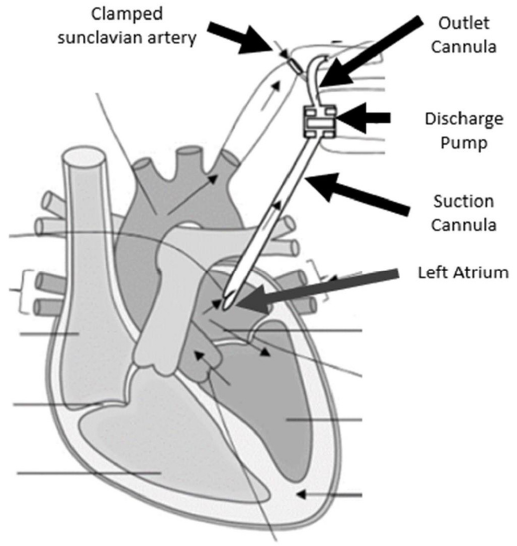
Figure 1. An illustration of how the developed pump will be implanted. The speci fi cations for this pump include a centrifugal pump with a volute and a semi- open impeller. The impeller is driven by an electric motor with axial fl ow and magnetic levitation. The rotational speed should be between 2000 and 5000 revolutions per minute, with a continuous fl ow rate ranging from 0.05 to 0.5 L/min depending on the required ejection fraction. The pressure gradient should be approximately 80 mm Hg to overcome the pressure loss in the organs supplied by the subclavian artery. It is important to note that the two pump prototypes are not commercially available and will be designed and manufactured in-house. In this study, two geometric variants of the pump were designed to meet the speci fi - cations and they di ff ered in blade thickness. The impellers and volutes were designed using internal 3Dturbo software, V2.0 a comprehensive solution for the design of single- stage centrifugal pumps. This software also allowed for the reverse engineering of centrif- ugal pumps and facilitated the calculation of performance in design and o ff -design con- ditions using a speci fi c 0D/1D solver, as explained in more detail in [23]. The impellers and volutes were then fi nalized in CATIA. Apart from a few key dimensions chosen rationally, there are many degrees of free- dom available to the centrifugal pump designer to de fi ne the other design parameters of the impeller and volute. Therefore, it is necessary to initially choose some design dimen- sions arbitrarily or intuitively and later verify, through simulations and/or experimental tests, if they meet the requirements. Two impellers, each with 5 blades, were designed with di ff erent blade thicknesses, in values and along the span. These impellers have a constant width of 9 mm, with only 2 mm allocated to the blade width and the remaining 7 mm to receive the magnets necessary for electric motorization and magnetic levitation. The main geometric characteristics of the impellers are given in Table 1, and the associated clearance gaps are shown in Figure 2. Stereolithography (SLA), an additive manufacturing technique, was used to fabricate the components of the two prototypes: a clear resin (product code: FLGPCL04) for the volute and a black resin (product code: FLGPBK04) for the impellers. Figure 3 shows the